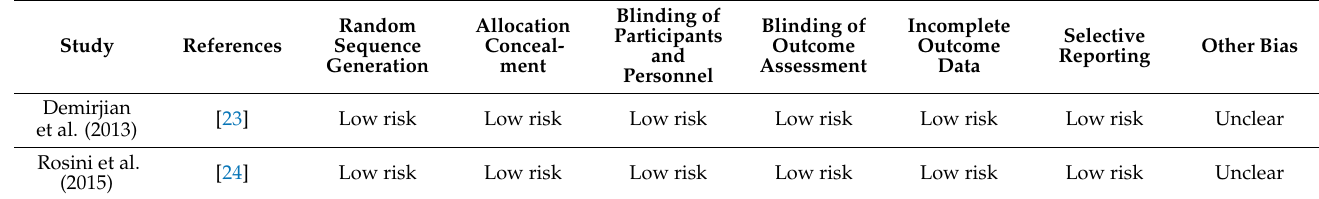
Table 3. Risk of bias assessment for randomized controlled